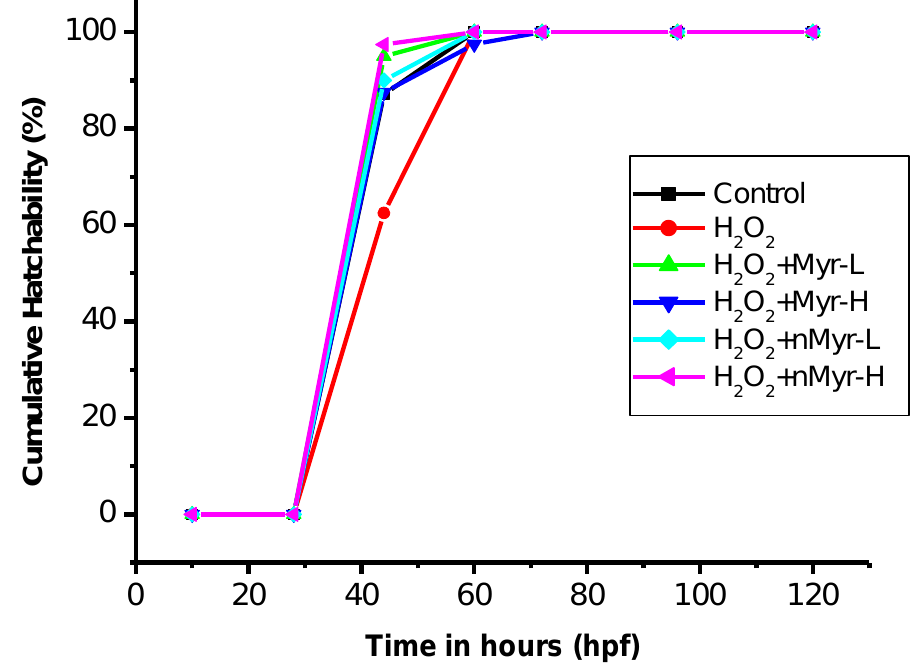
Figure 6. Percentage cumulative hatchability for hydrogen-peroxide-treated embryos after exposure to myricetin and nano-myricetin treatment at low and high doses.